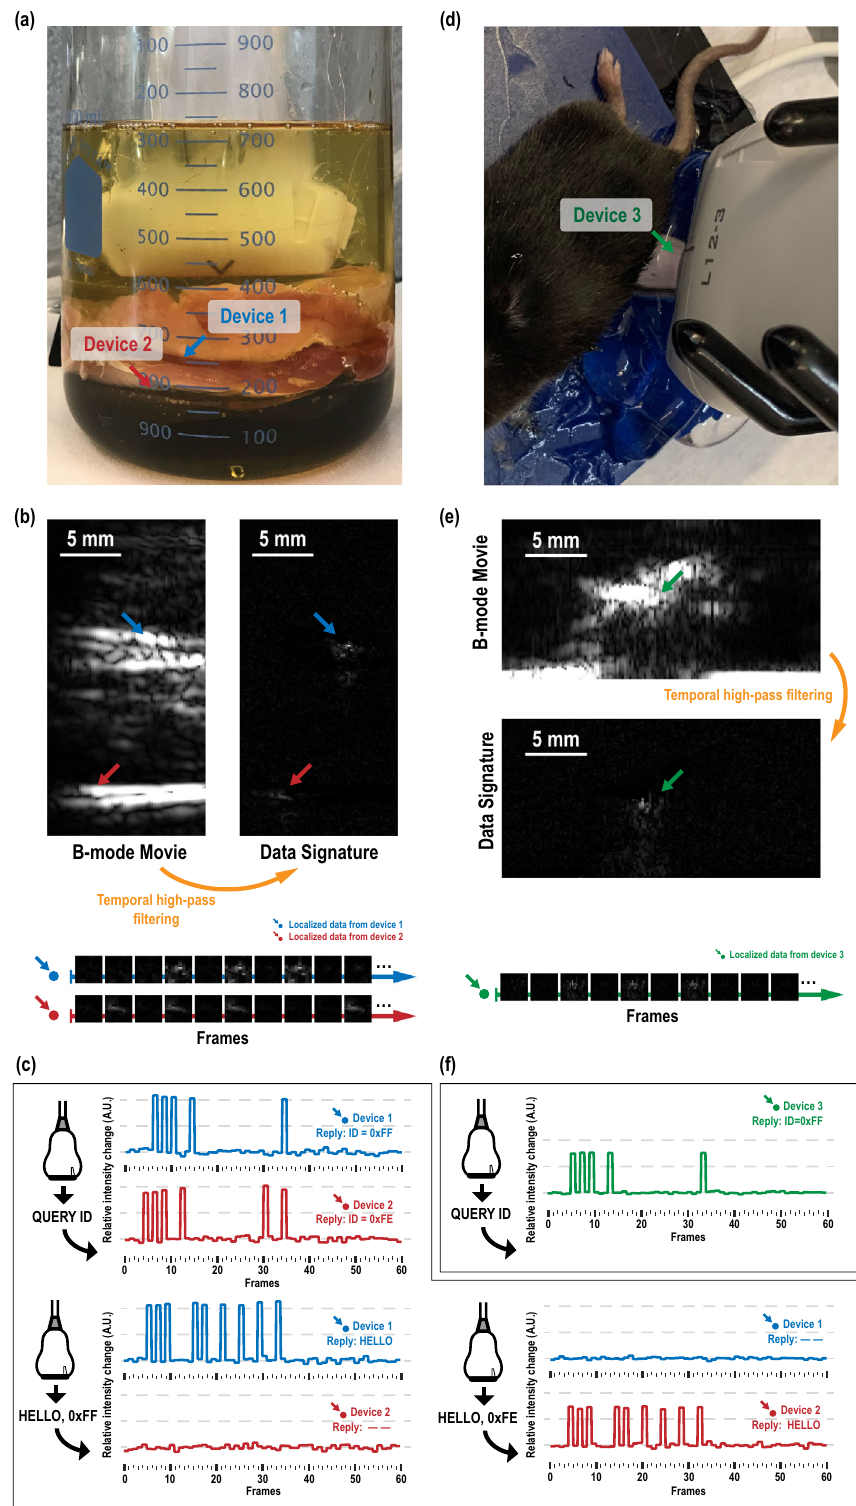
Fig. 6 Measured response from the mote in both in vitro and in vivo environments. a Setup with two devices embedded in layers of chicken breast, with approximate mote locations overlaid; b the B-mode movie captured by the imaging system, where temporal average removal is used to reveal locations with abrupt, frame-to-frame intensity changes (plotted versus frames at the bottom); c detailed timing diagram showing instructions sent from the transducer and the motes ’ replies (in frame-domain, a detected change implies a bit 0, information translated according to Supplementary Table S3/S4); d a setup with one devices implanted in the mouse ’ s hindlimb; e the B-mode movie and data pattern from the mote for this in vivo experiment; and f detailed timing diagram showing the interaction between the imaging system and the implanted